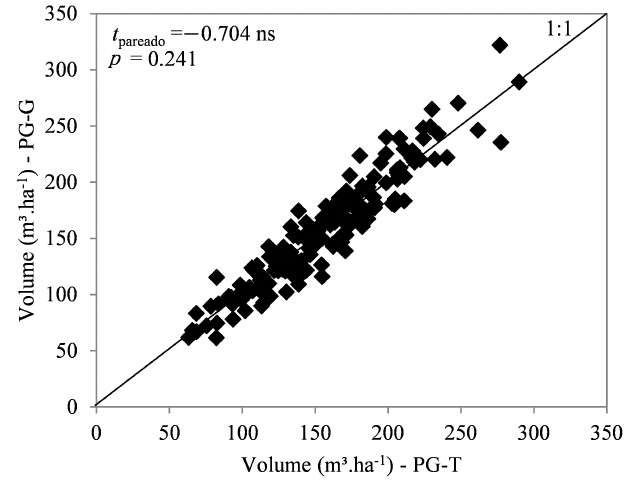
Figure 2. Correlation between initial volume of twin (TP) and normal (NP) plots.